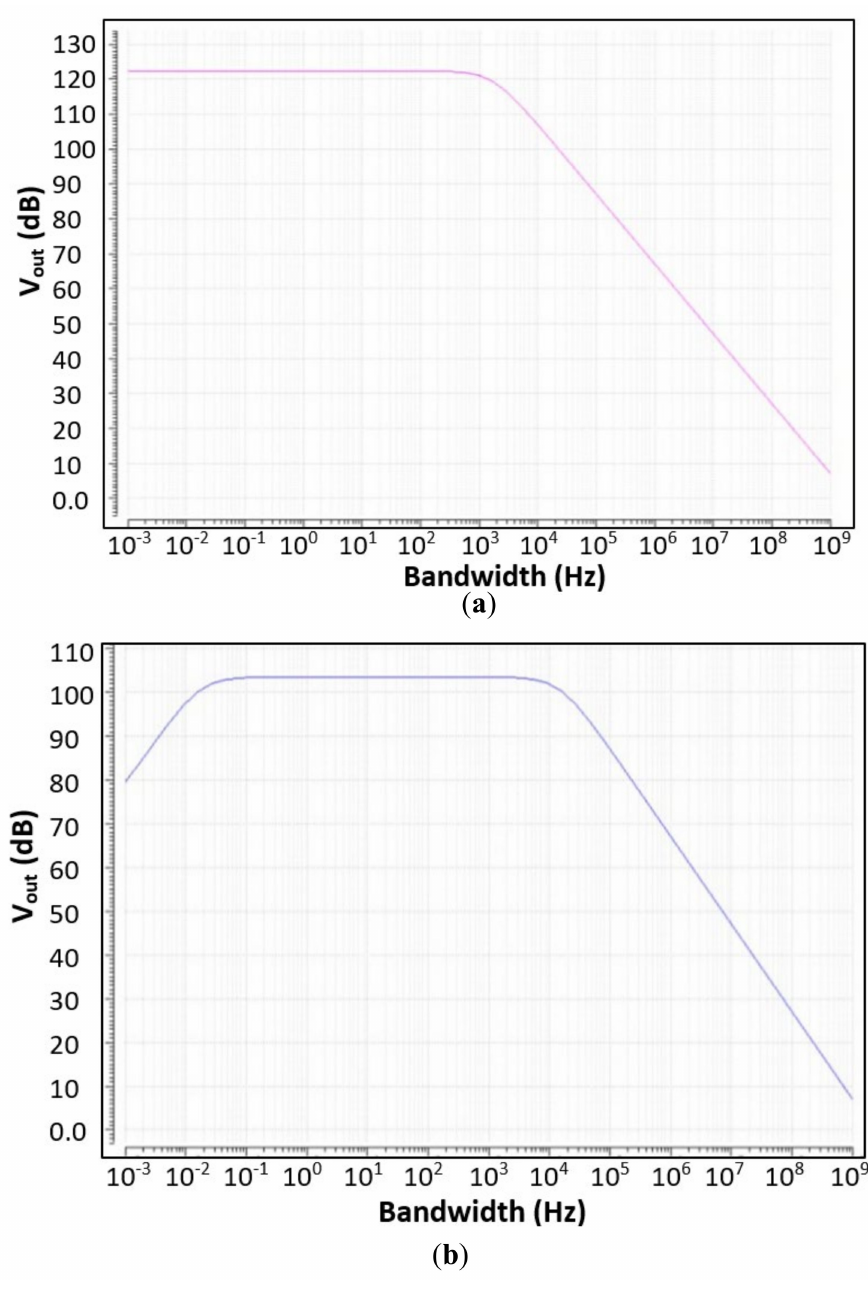
Figure 4. Frequency response at ( a ) I ph = 1 nA, ( b ) I ph = 200 µ